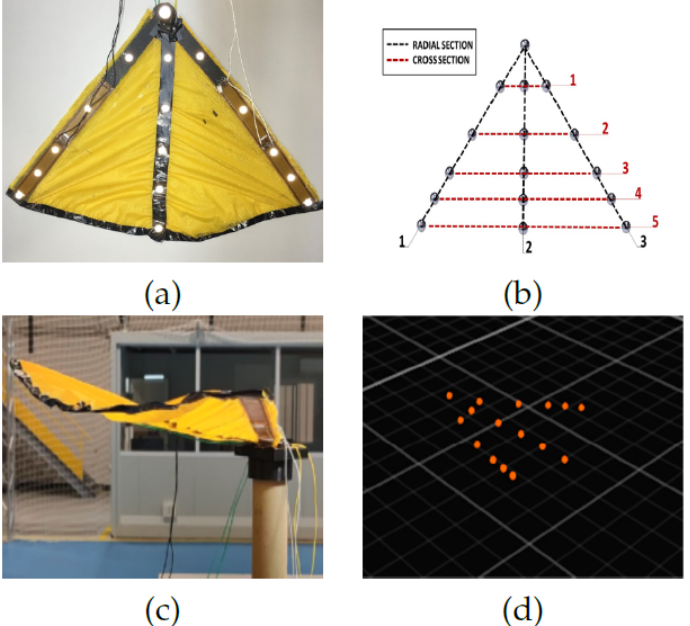
Figure 12. Tail Optitrack Representation. ( a ) Shows the markers distribution on the real tail prototype. ( b ) Shows the pattern wanted for performing the mesh. ( c ) Shows the real tail raise view applying 1500 V. ( d ) Shows the markers as seen in the